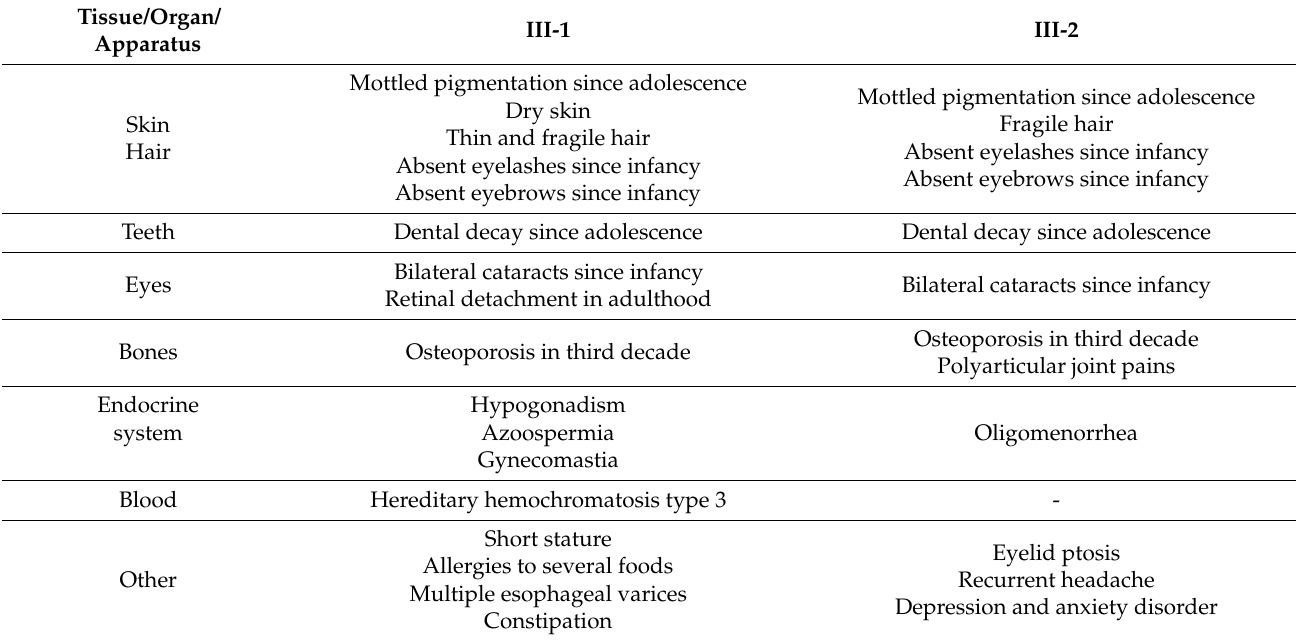
Table 1. Overall clinical phenotype of the affected